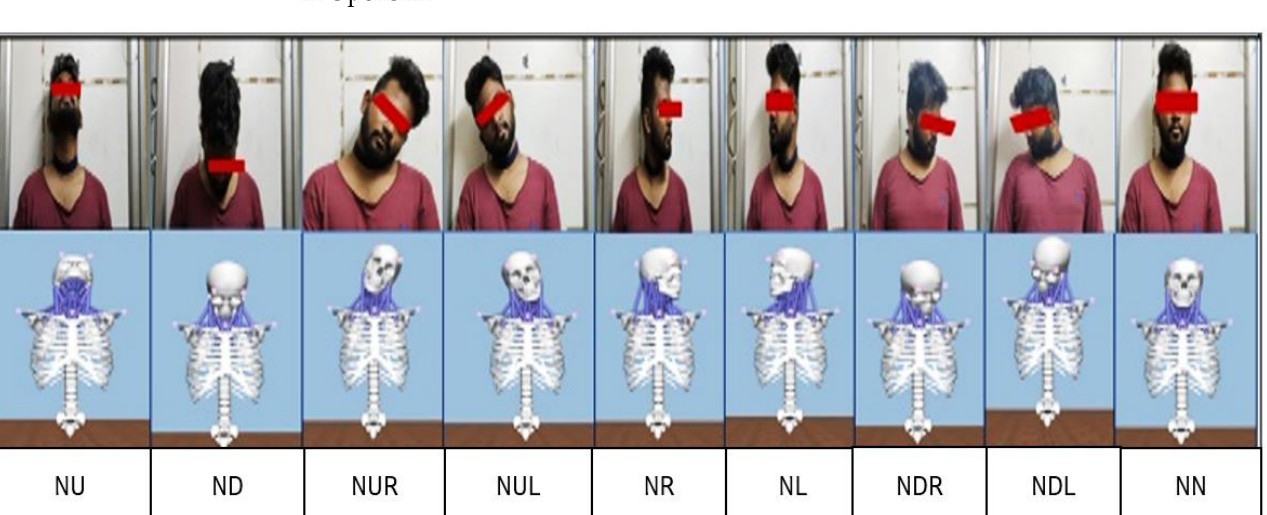
Figure 6. ( a ) Machine Learning algorithms — accuracy of the classification models; ( b ) confusion matrix — classification of neck posture based on sensor position; ( c ) performance metrics.